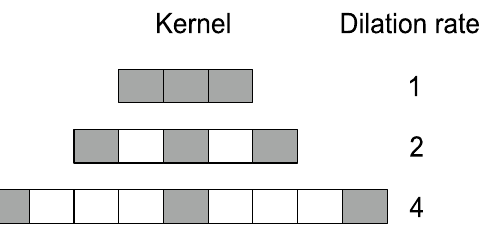
Figure 5. Receptive field of the kernel increases when dilation rate is increased. Grey denotes kernel weights while white indicates skipped inputs.